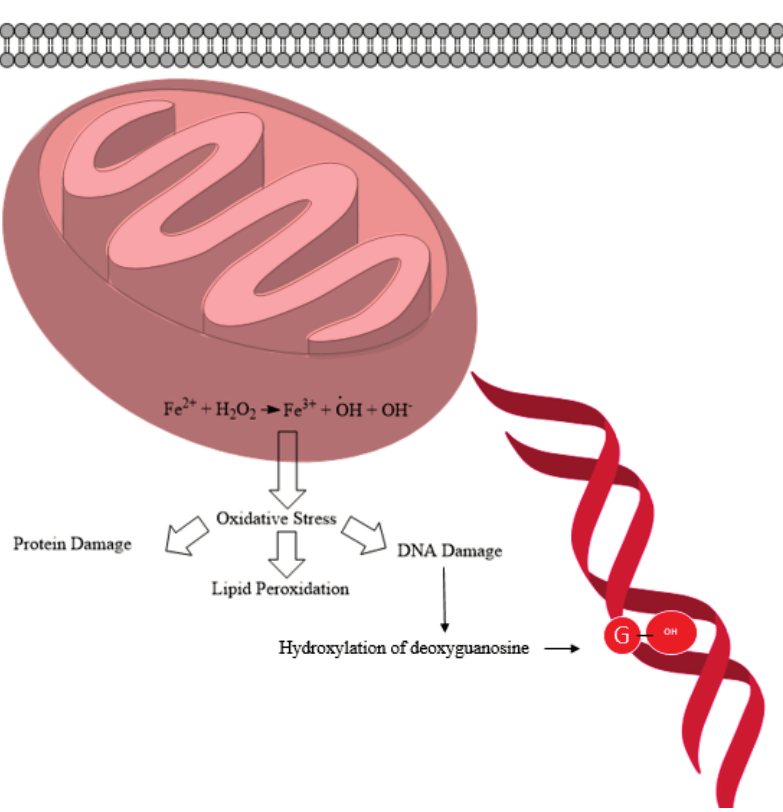
Figure 4. Schematic diagram showing the fate of iron oxide nanoparticles (IONPs) inside a cell leading to mutagenicity, hydroxylation of the deoxyguanosine (pictured as a circled “G”). Hydroxyl radicals can abstract a H atom from the sugar component of DNA as shown in Figure 5 at rate constant of 2 × 10 9 M − 1 ·s − 1 . The C4 ʹ -radical of the deoxyribose sugar in DNA can undergo several reactions, which lead to DNA strand breakage. The breakage of the strand may be due to release of free modified sugars or sugars with terminal groups of broken DNA